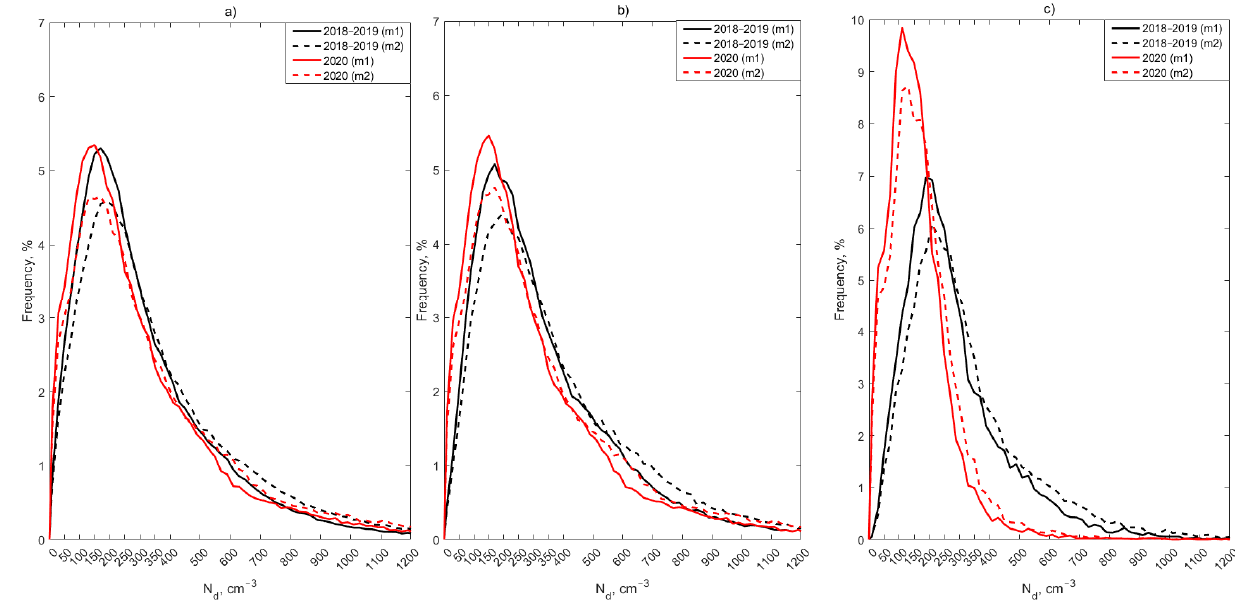
Figure 4. Frequency distribution of N d by the two methods in April–May 2020 and 2018–2019 for three samples: ( a ) all cases, ( b ) northern advection cases, ( c ) NWP cases.